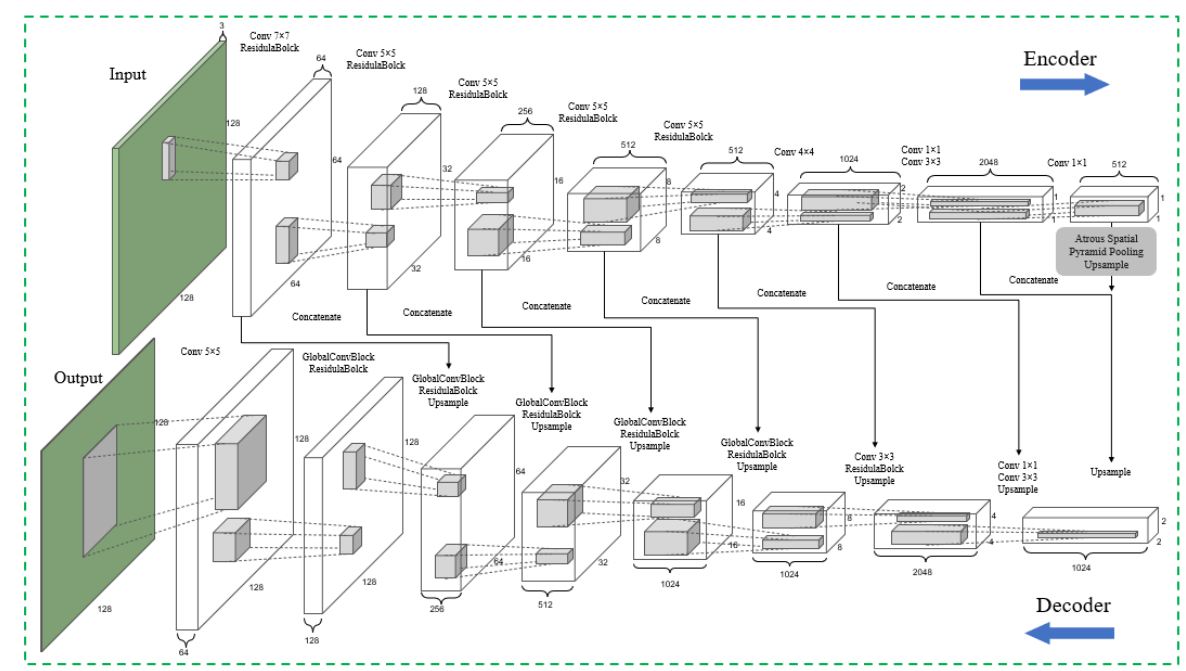
Figure 2. Structure of Segmentation Network.